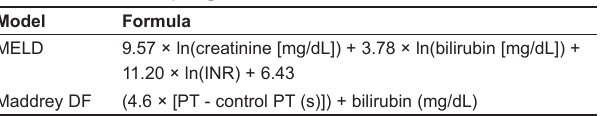
DF Discriminant function; INR International normalized ratio; MELD Model for End-stage Liver Disease; PT Prothrombin